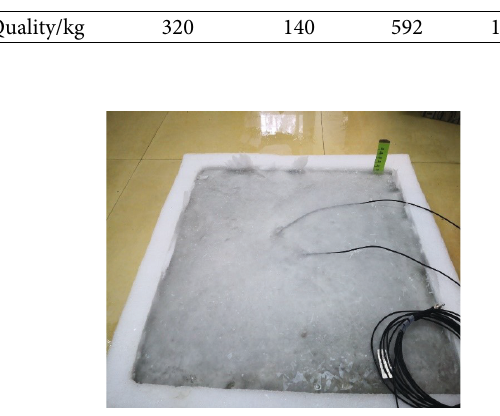
Figure 2: Ice layer preparation.